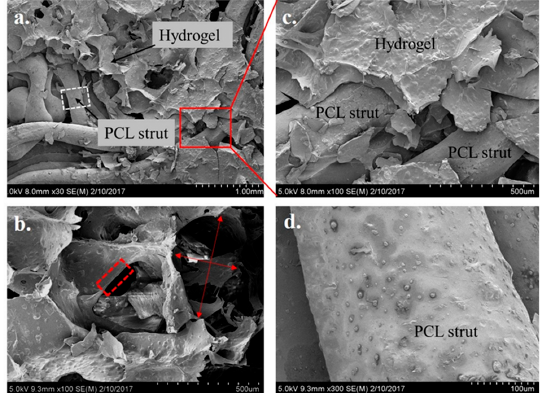
Figure 2. Scanning electron microscope (SEM) images of freeze-dried polycaprolactone (PCL)-gel samples ( a ). A high magnification image confirmed the highly porous nature of the hydrogel with interconnected pores. The pore shape and pore wall thickness are marked with a cross-arrow and a rectangular box, respectively ( b ). A magnified image of region marked with rectangular box in ( a ) showed complete adherence of hydrogel on the scaffold, which is expected to provide a bioactive coating to the otherwise bioinert surface of PCL ( c ). The PCL scaffold was characterized by surface micro-roughness and non-homogeneity ( d ). Gels 2017 , 3 , 26